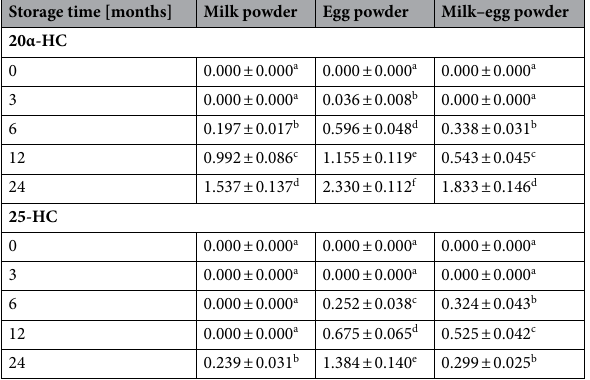
Table 6. Content (µg g −1 powder) of 20α-HC and 25-HC in powders. a,b —different letters within the column denote statistically significant differences between the results (P < 0.05); ± means